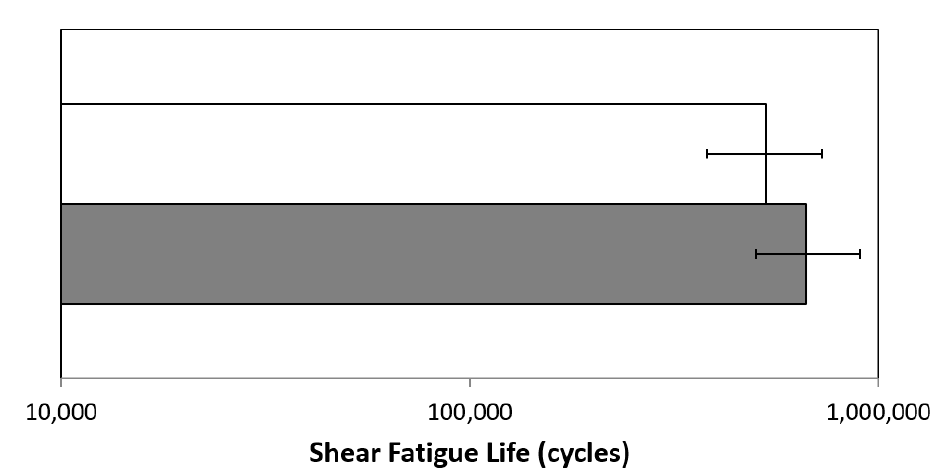
Figure 7. Average shear fatigue life of specimens: Baseline open symbol, collar replacement filled symbol (error bars represent ±1 standard deviation, assuming a log-normal fatigue life distribution).